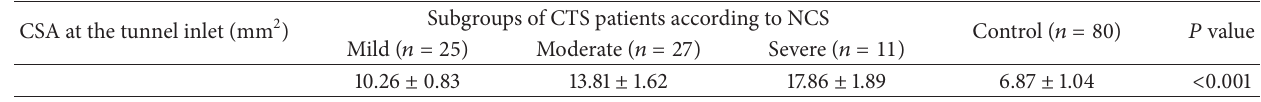
Table3:TheCSAofMNsforthedifferentpatientsubgroupsversusthatofthecontrolgroup(dependingontheresultsofthenerveconducting study).